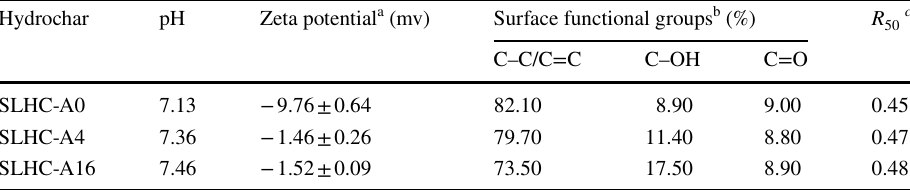
Table 2 pH, zeta potential, surface functional groups and recalcitrance index ( R 50 ) of fresh and aged sludge-derived